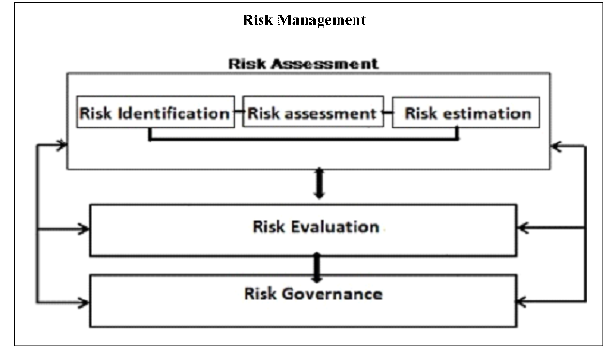
Figure 1. Components of drought risk management (adapted from Dalezios et al.,